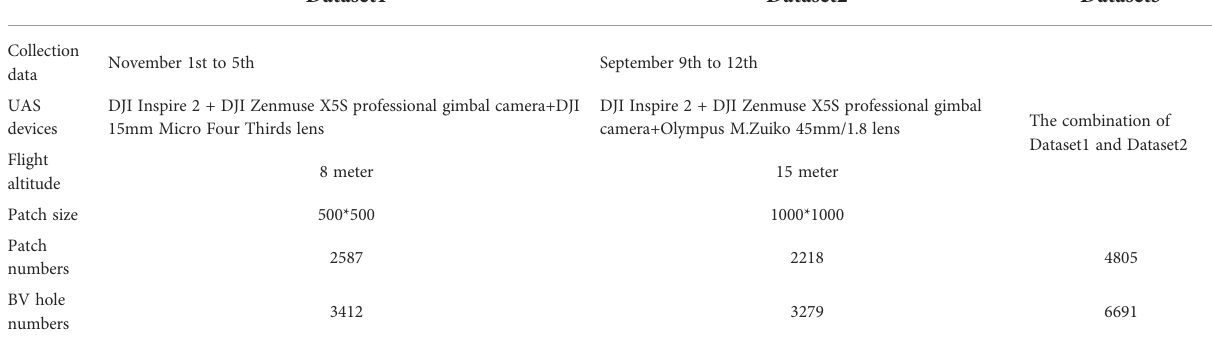
TABLE 1 Datasets information.